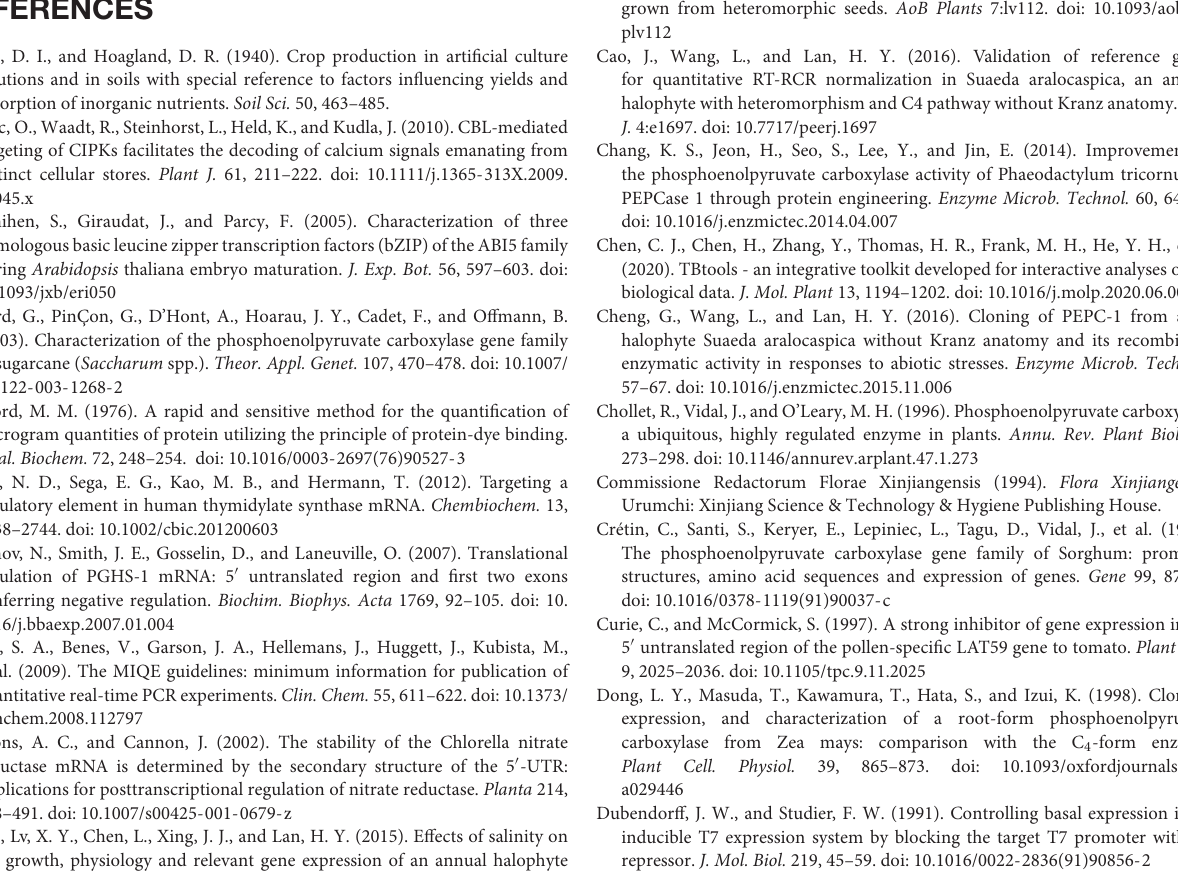
Supplementary Figure 2 | Analysis of exons and introns in PEPC genes of different plant species. (A) Plant-type PEPC (PTPC) genes of dicots; (B) PTPC genes of monocots, mosses, and ferns; (C) Bacterial-type PEPC (BTPC) genes in plants. Supplementary Figure 3 | Distribution of conserved motifs in PEPC genes of different plant species. (A) PTPC genes of dicots; (B) PTPC genes of monocots, mosses, and ferns; (C) BTPC genes in plants; (D) Schematic diagram of base enrichment of top 10 motifs. The five-pointed star represents the active site of PEPC enzyme. Supplementary Figure 4 | Subcellular localization of SaPEPC-2 in tobacco epidermal cells. CBL1, calcineurin B-like protein 1, membrane marker control; ABI5, abscisic acid insensitive 5, nucleus marker control; GFP, green fluorescent protein. Bar = 20 µ m. Supplementary Figure 5 | Analysis of 5 (cid:48) -UTR sequence of two SaPEPC promoters. (A,B) SaPEPC-1 ; (C,D) SaPEPC-2. (A,C) Secondary structure of